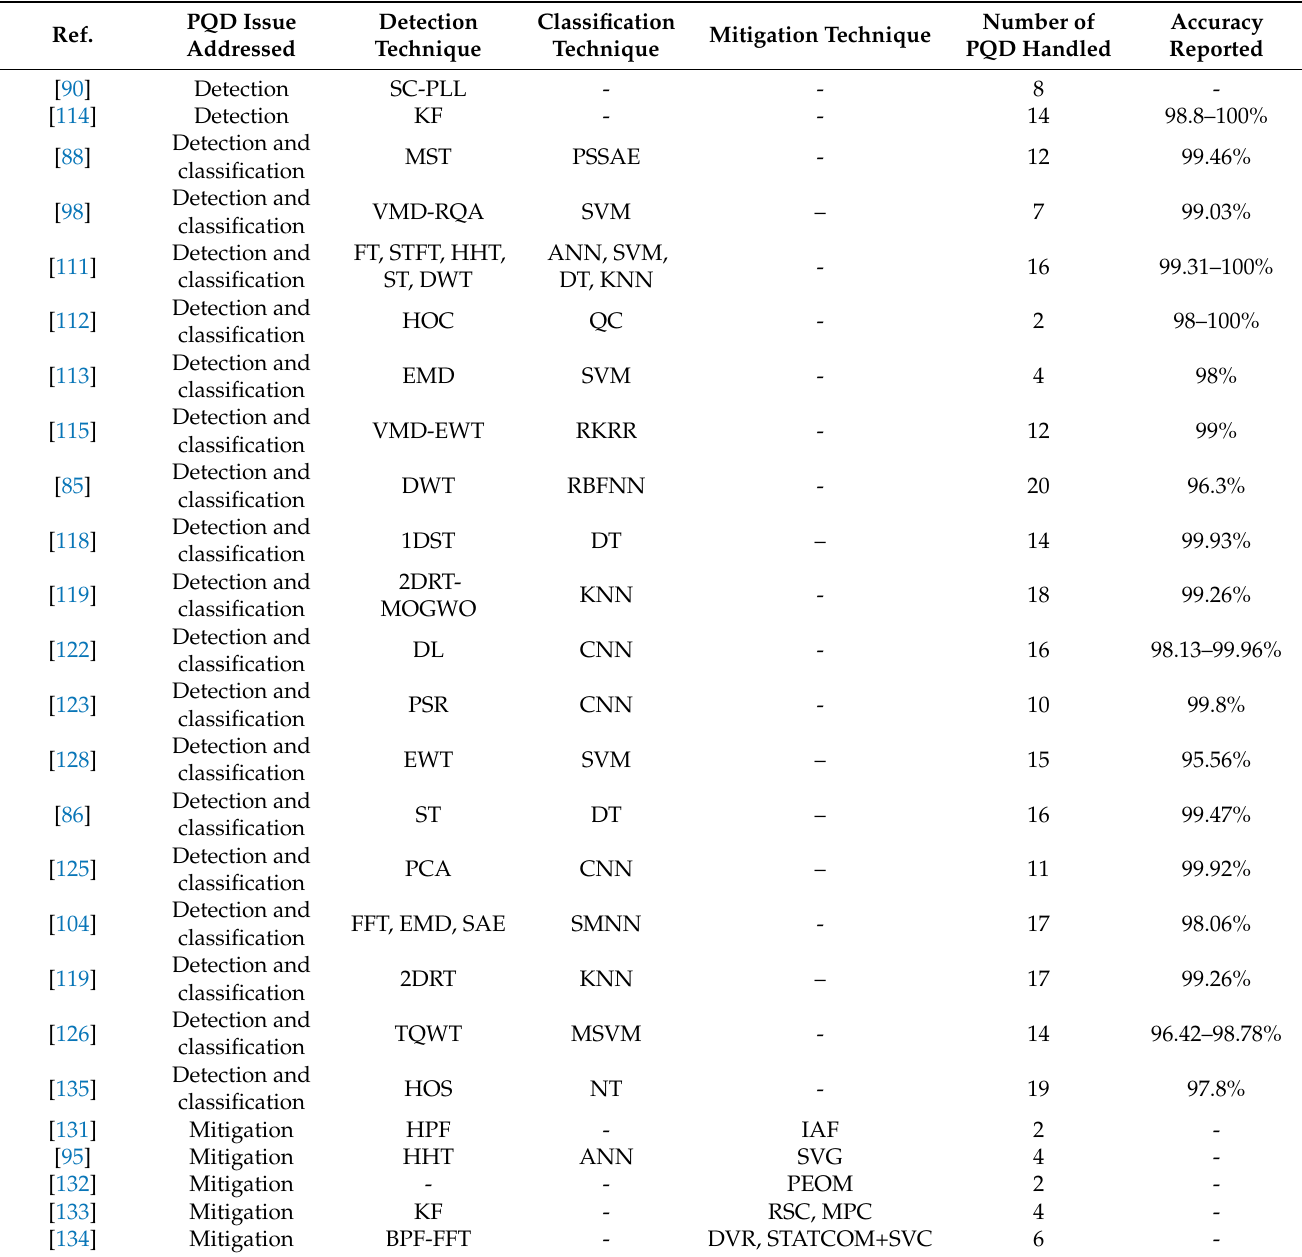
Table 4. Comparison of PQDs studies in the literature.